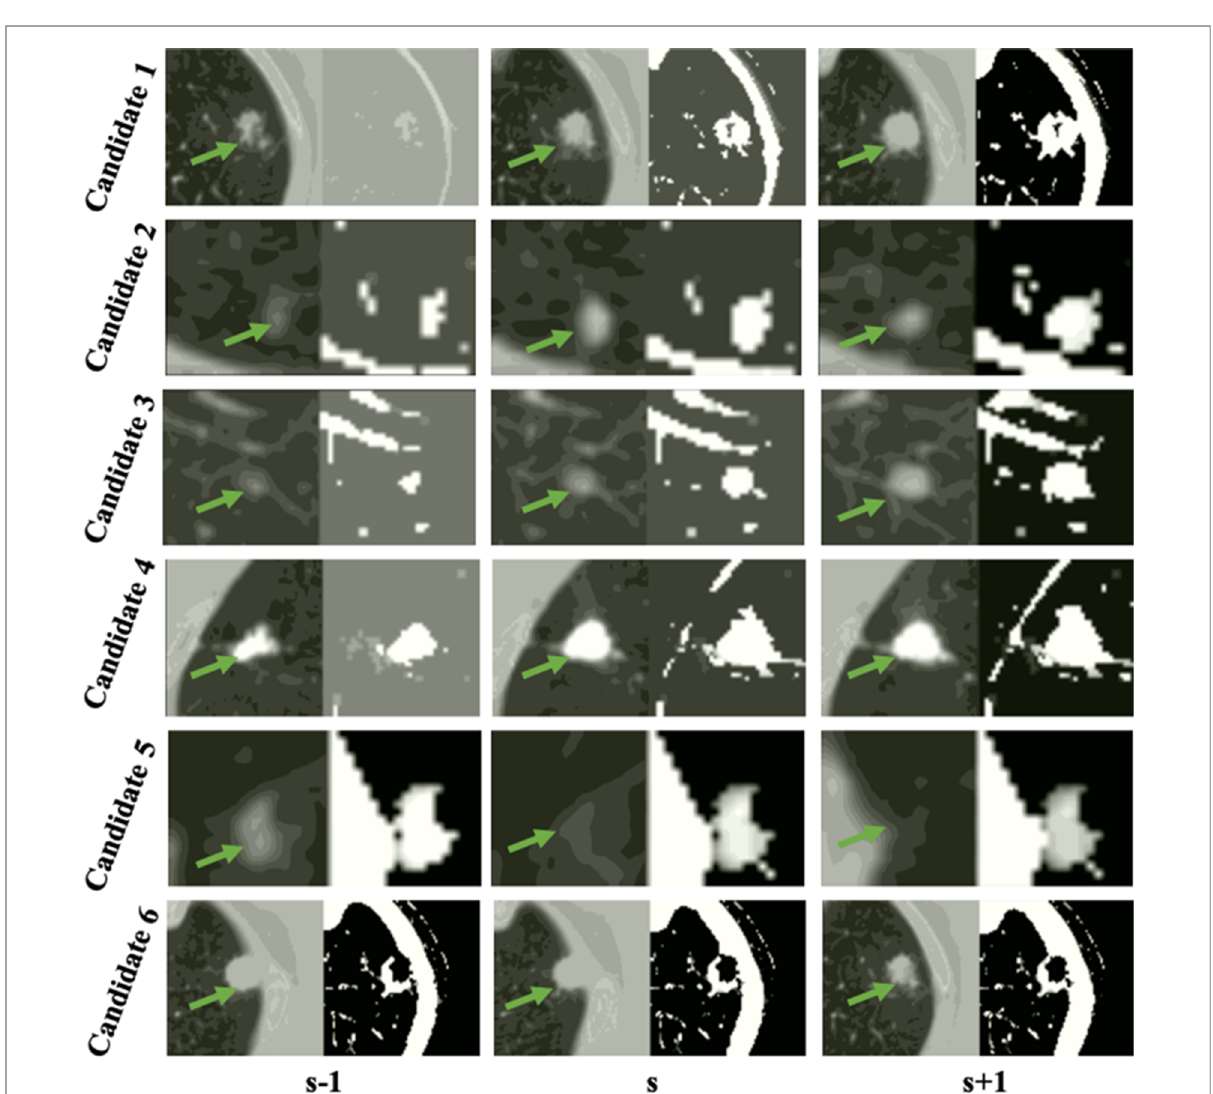
FIGURE 5 Examples of the detected true nodule candidates (the left image of each column) and their corresponding LHIs (the right image of each column) calculated between ( s (cid:4) 2, s (cid:4) 1), ( s (cid:4) 1, s ), and ( s , s þ 1) slices shown in the s (cid:4) 1, s , s þ 1 columns. The green arrows mark the position of candidates. As shown in the fi gure, the true nodules have a circular region on LHI images as the location of the nodule approach to the center or the edge of nodule volume. Furthermore, the center location of the nodule candidates barely changes in the continuous